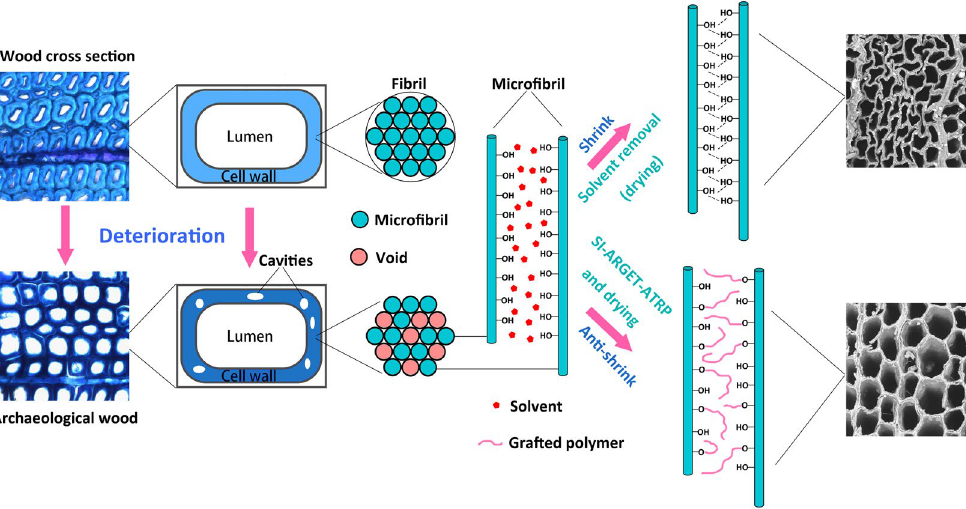
Figure 1. Scheme depicting the conceptual process of grafting polymer chains within wood cell wall using ARGET